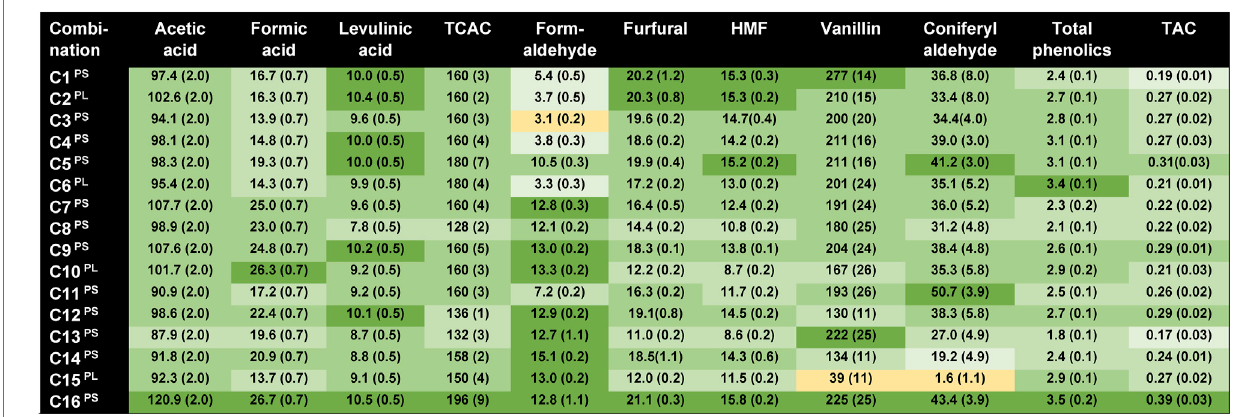
FIGURE 4 | Measurements of bioconversion inhibitors in the pretreated slurry (PS) and hydrolysate (PL) with and without sodium dithionite, sodium sul fi te, sodium borohydride, calcium hydroxide, activated charcoal, and hydrogenation. Concentrations of bioconversion inhibitors are indicated in mM, except for vanillin and coniferyl aldehyde ( μ M), total phenolics (g/L with vanillin as calibration standard), and TAC (UV absorption at 280 nm with a dilution factor of 500). The concentrations are mean values of three replicates, with standard deviations indicated in parentheses. Effects are color-coded in relation to C16 PS (untreated reference), with lighter colors re fl ecting lower concentrations in relation to C16 PS : (dark green) 95% or higher, (medium green) 75 – 94%, (light green) 50 – 74%, (very light green) 25 – 49%, and (yellow) <